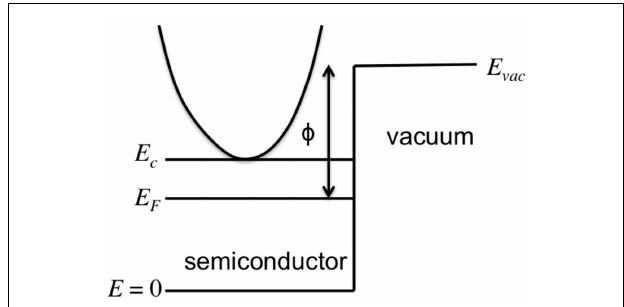
FIGURE 2 | Energy level diagram for a semiconductor with a parabolic conduction band next to vacuum .